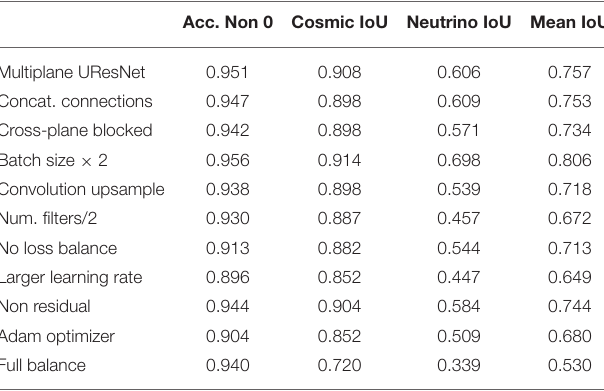
TABLE 2 | A comparison of the performance metrics for the various networks trained.